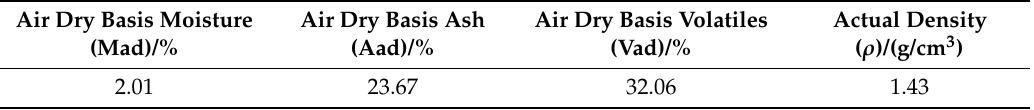
Figure 1. Collection site of coal samples and the process of preparing broken coal samples. ( a ) Sample collection site; ( b ) The process of preparing broken coal samples. Table 1. Results of proximate analysis of coal samples.